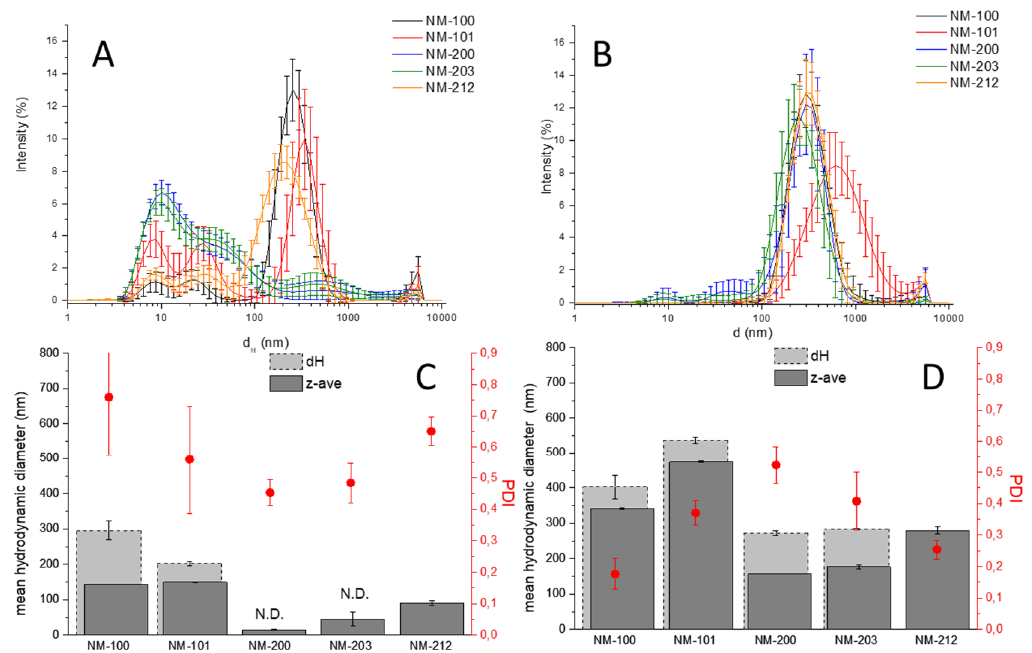
Figure 4. DLS analysis of the NM in RPMI. ( A , B ) d H distribution; ( C , D ) mean hydrodynamic diameters (Z D dark grey bars and d H light grey bars) and PDI values; nanomaterials concentration: 1 ( A , C ) and 100 µg/mL ( B , D ) N.D.: not determined.